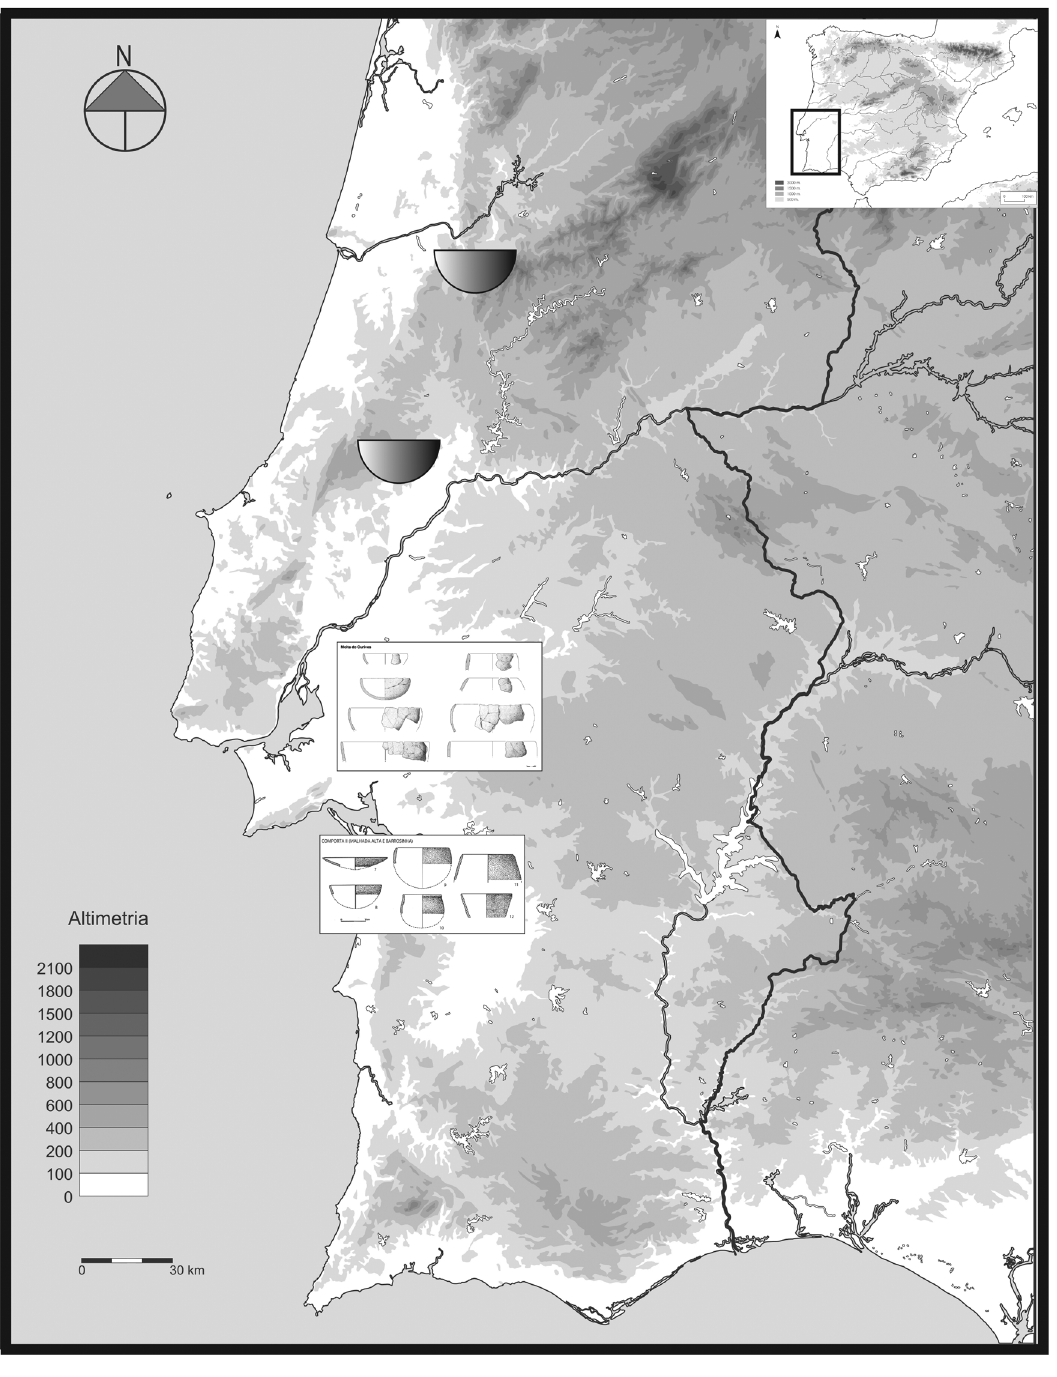
Figure 9: Full Moment of the Middle Neolithic ( ∼ 3700 – 3300 cal BC ) : Pottery decoration systems distribution ( according to: Carvalho, 2016; Neves, 2018; Soares & Silva, 2013; Valera, 2013; basemap: Boaventura, 2009; Trabajos de Prehistoria for the map of Iberia )